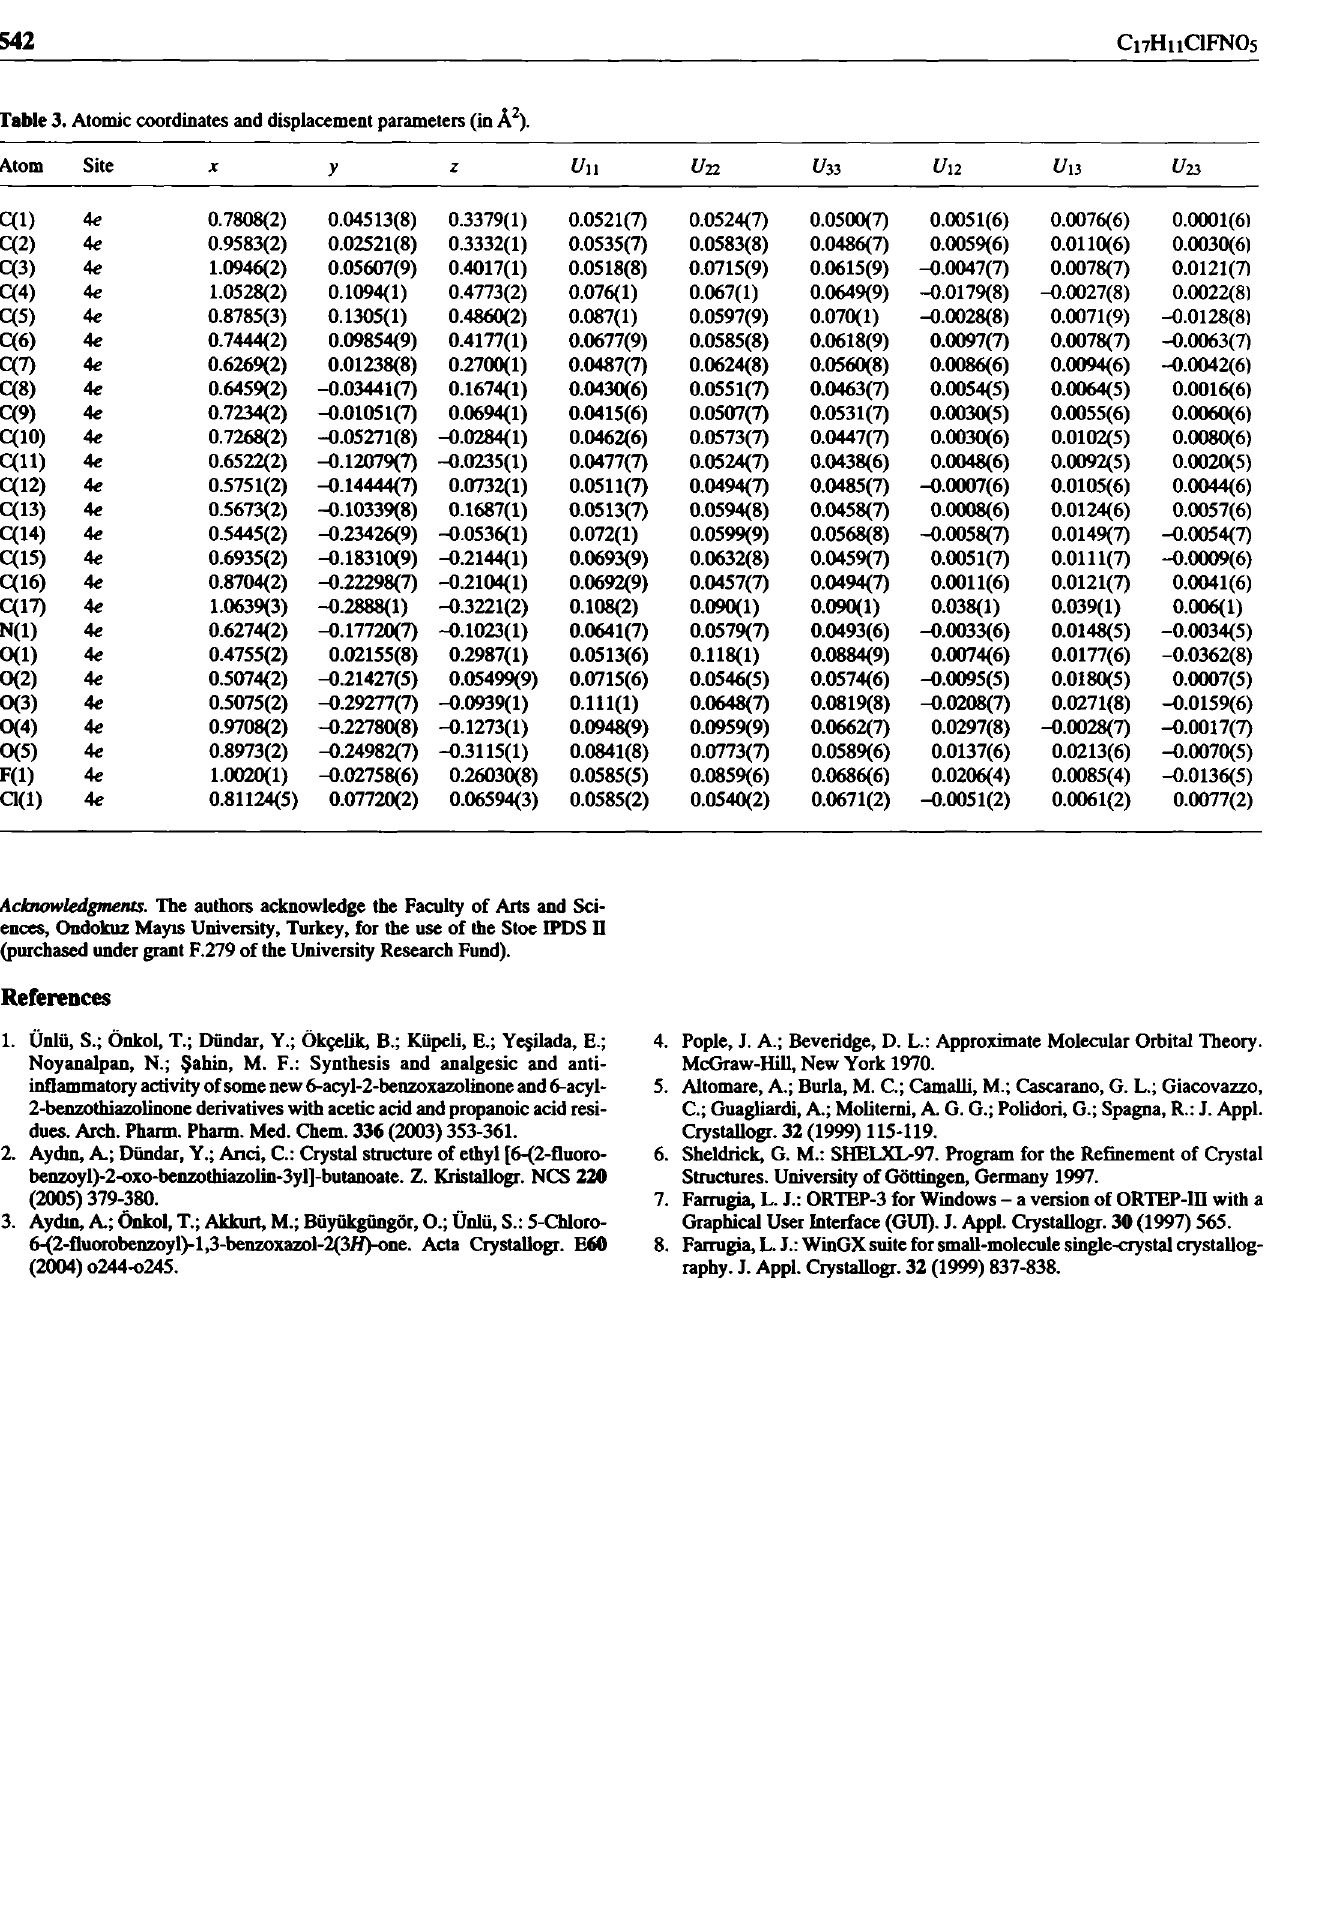
Table 3. Atomic coordinates and displacement parameters (in A 2